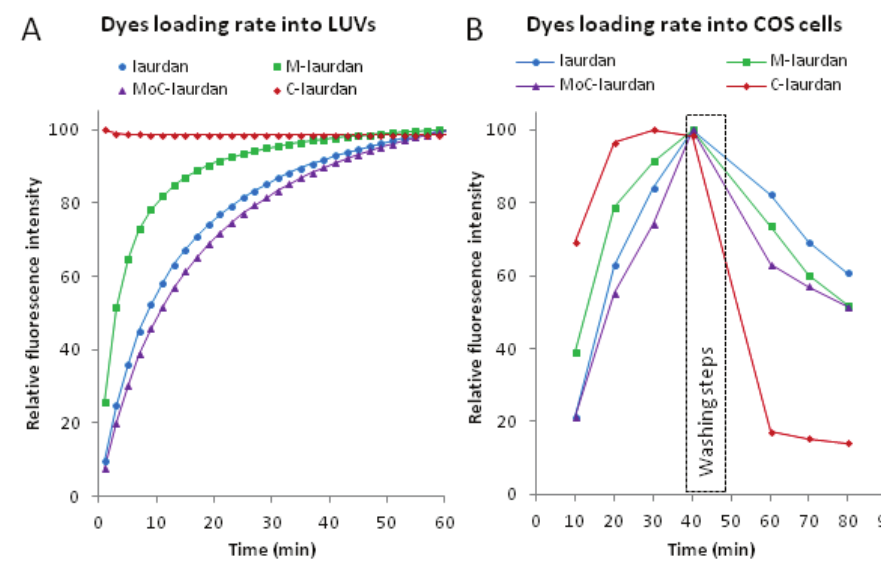
Figure 3. Time dependence of dyes incorporation into LUVs and COS7 cells. A (Left panel): Incorporation of the dyes into LUVs resulted in an increase of the fluorescence intensity over time. Unlabeled LUVs made of DPPC/chol (6:4) (100 µM, sample volume 3 ml) were mixed with dyes dissolved in DMSO. The final dye concentrations were 1 µM and the DMSO/water ratio 1:1000. Measurements were carried out at 20°C and fluorescence intensities were recorded at 440 nm. The fitting curve was obtained using a one site binding equation. B (Right panel): For flow cytometry (FACS), cells were harvested as a single cell suspension in tissue culture medium + serum after trypsinization and washed twice with PBS with no serum. For each probe, 1 µl of stock solution at 2 mM in DMSO was mixed with 2 million cells in 200 µl PBS (10 µM final) at room temperature. After 10 minutes, the tubes were placed in a water bath at 37°C for 30 min, before cells were washed twice in 5 ml and resuspended in a final volume of 1 ml with PBS + 10% serum warmed to 37°C. Cells were then further incubated for 20 min at 37°C. Every 10 minutes throughout the procedure, the volume corresponding to 250.000 cells was taken from each sample, placed on ice in a final volume of 500 µl ice-cold PBS + 10% serum, and submitted to FACS analysis on a LSR II flow cytometer with a UV laser and using the channel with a 450/50 BP